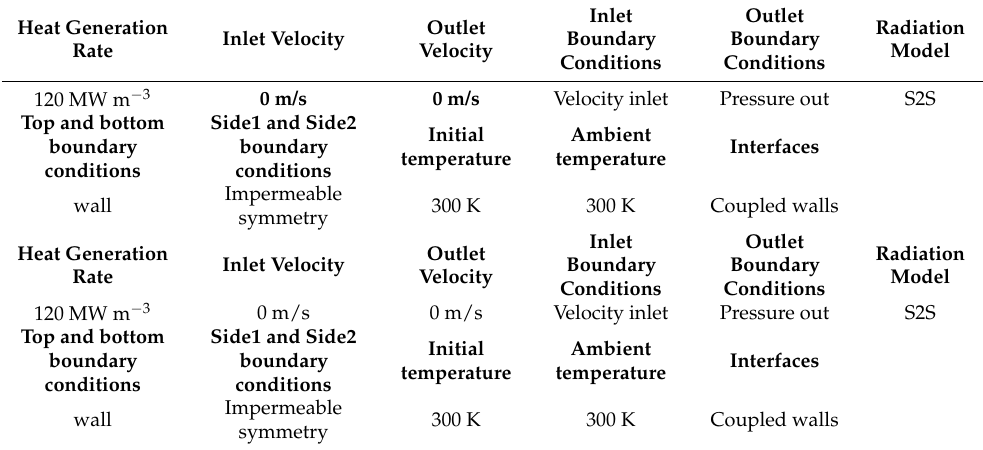
Table 4. The range/value of inputs.